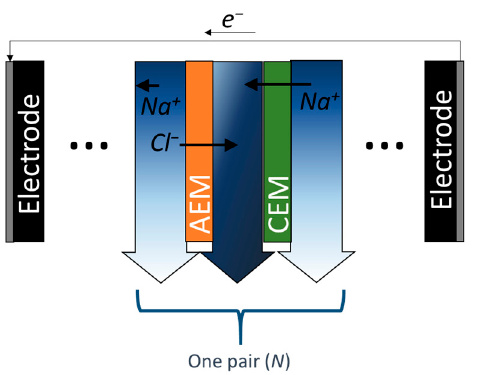
Figure 4. Schematic and working principle of electrodialysis (ED) that becomes the reverse electrodialysis (RED) mode where current flows in the external circuit when solutions with different salinities flow without applying current to the system.